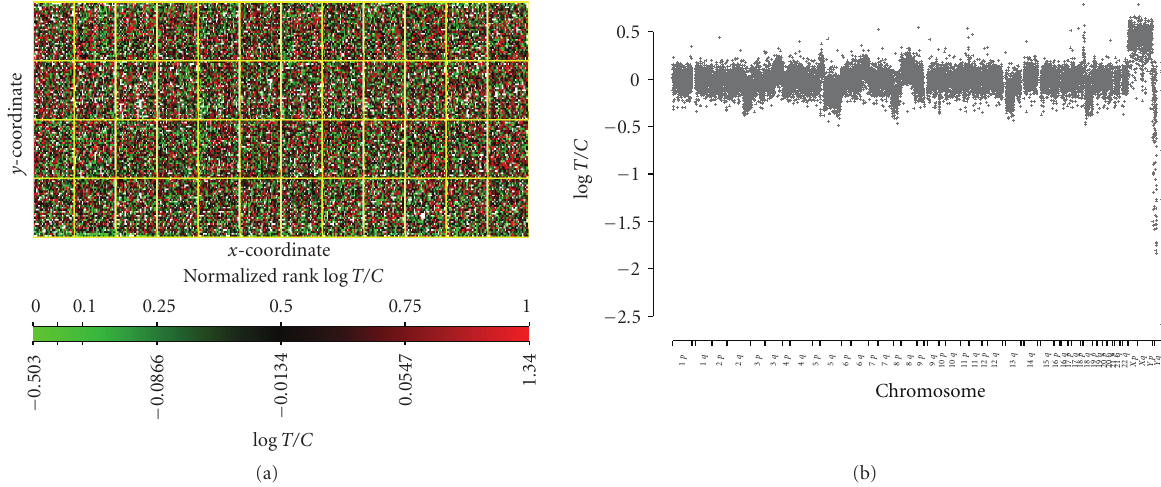
Figure 5: Spatial correction results: (a) The array image after spatial correction (and intensity correction). (b) The genome plot of log T/C after spatial correction (and intensity